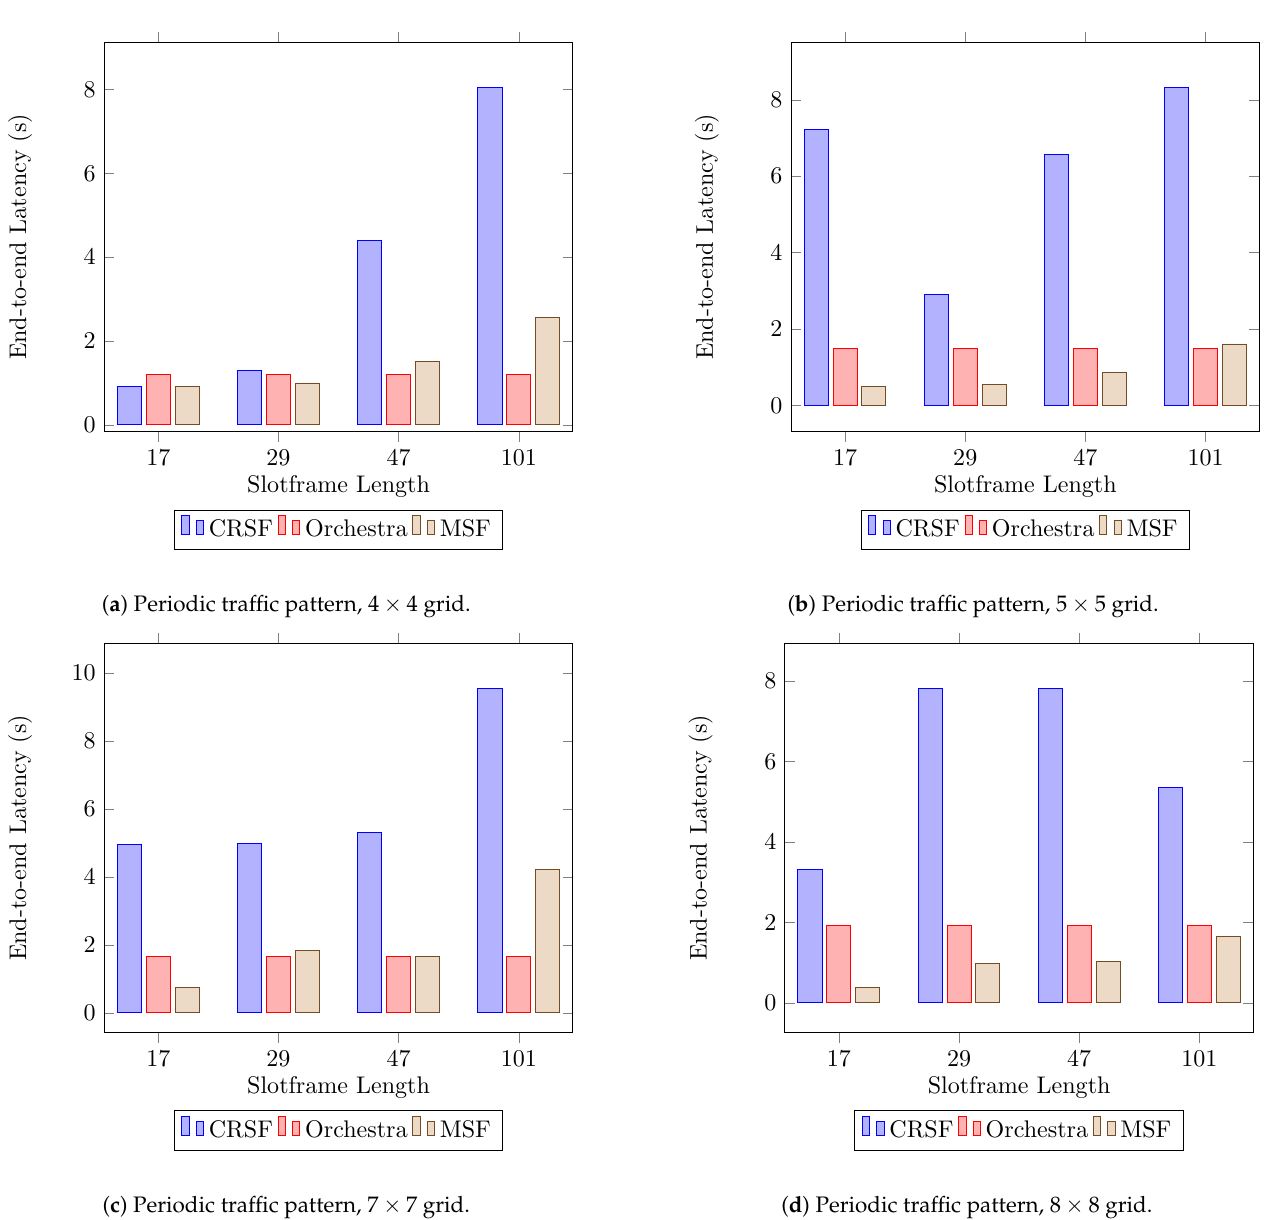
( c ) Periodic traffic pattern, 7 × 7 grid. ( d ) Periodic traffic pattern, 8 × 8 grid. Figure 6. Average end-to-end latency performance using a periodic traffic pattern. Lower is